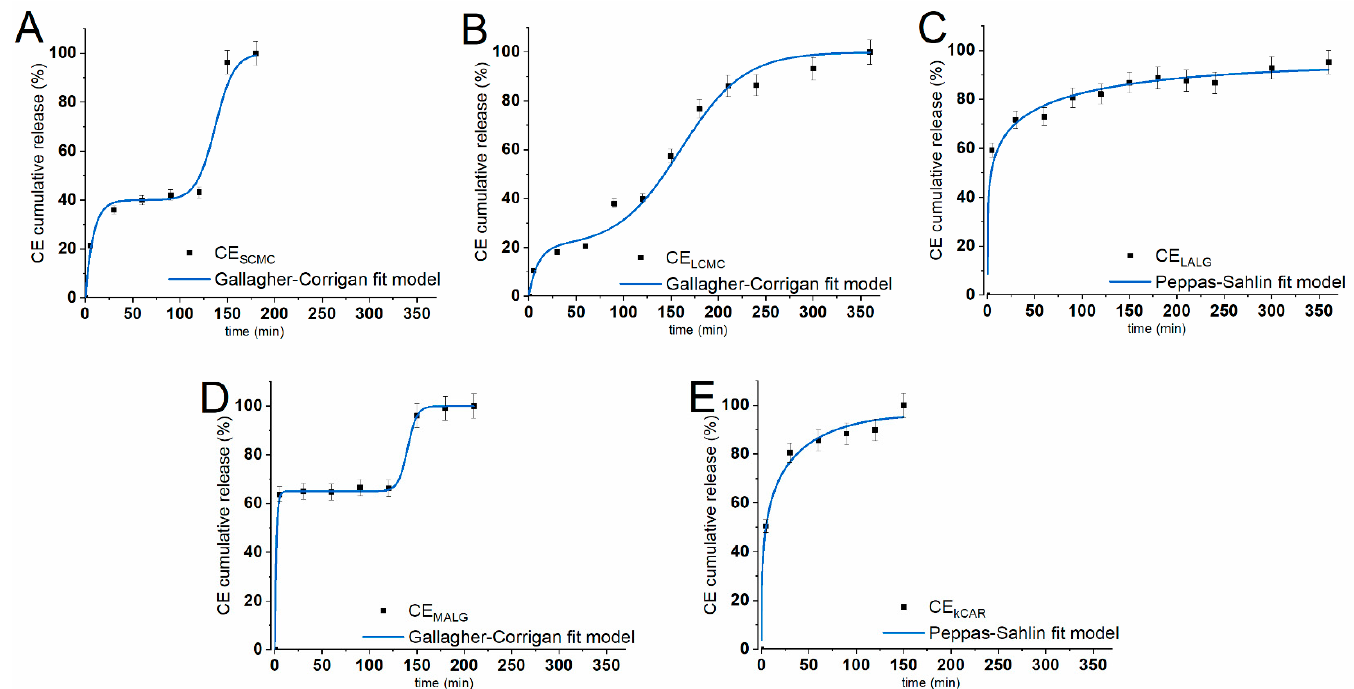
Figure 4. In vitro cumulative release profiles of CE from the polysaccharide microparticles (dots) ( A ) SCMC, ( B ) LCMC, ( C ) LALG, ( D ) MALG, and ( E ) κ CAR) under conditions simulating the stomach (0–120 min) and intestines (121–360 min). Solid lines correspond to CE release profiles that best fit the selected kinetic models, namely, the Gallagher–Corrigan and Peppas-Sahlin models. The results are presented as the means ± S.D.